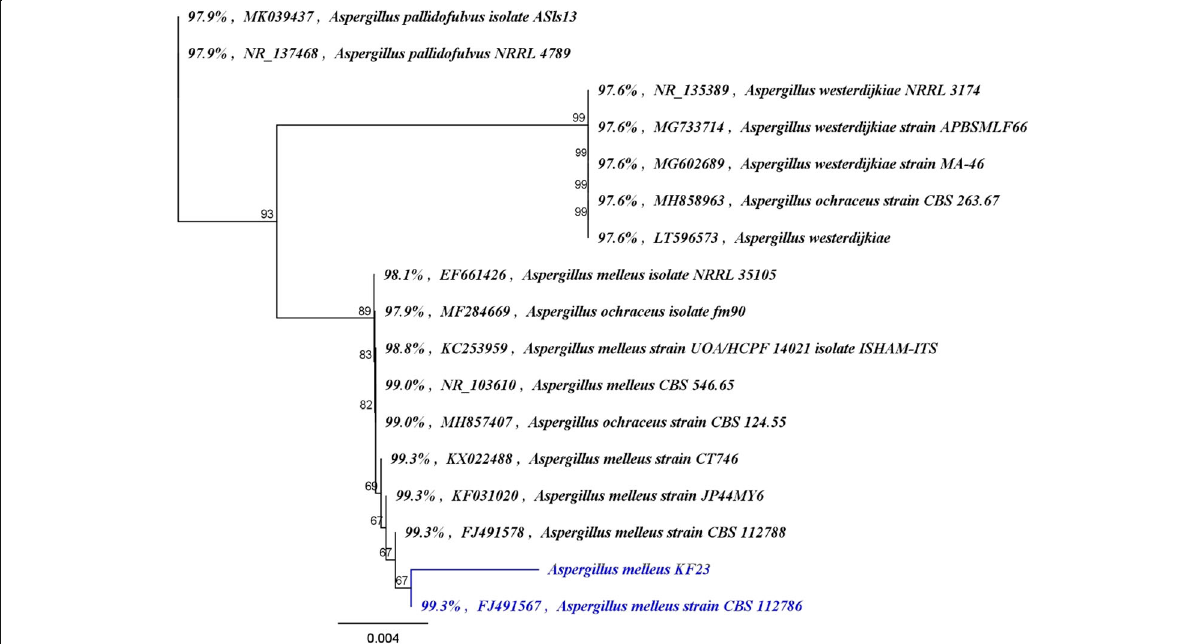
Fig. 1 Phylogenetic tree of the ITS region sequences of the fungal isolate ( Aspergillus melleus KF23) aligned with closely related sequences accessed from Gene Bank. Branches show bootstrap values (%), random seed (226,649), no. of replicates = 100; scale bar indicates nucleotides substitutions per